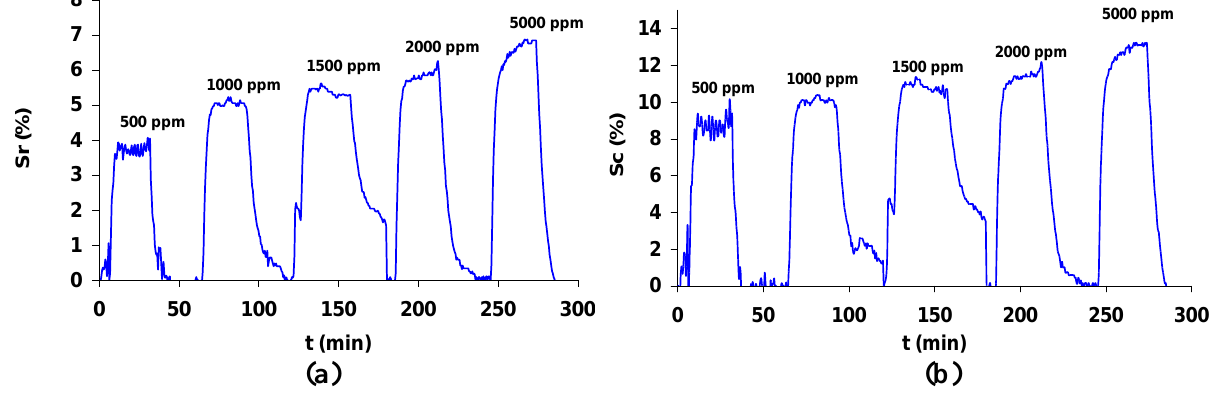
Figure 4. Dynamic response to carbon dioxide at a concentration of 500 to 5,000 ppm, measured at 300  C and 40% RH. (a) Resistance change. (b) Capacitance